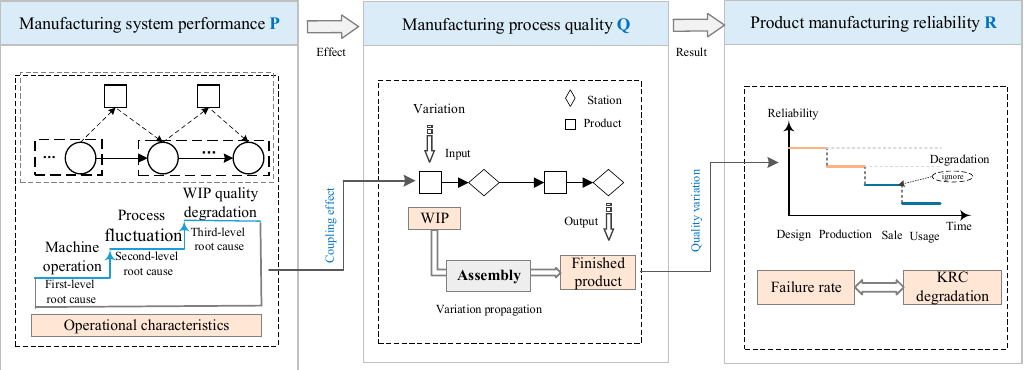
Figure 2. Conceptual modeling of product manufacturing reliability.